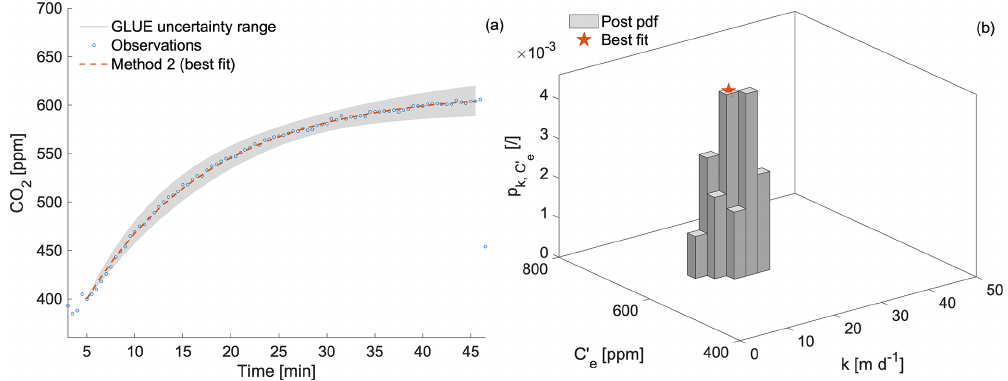
Figure 4. Panel (a) contains the observations of CO 2 with the flexible foil chamber – steady mode – for set-up 4. The curve in orange is the result of the fitting procedure with method 2. Panel (b) contains the bi-variate posterior PDF of k and C (cid:48) e ; the orange dot indicates the optimal parameters resulting from the fitting procedure with method 2.